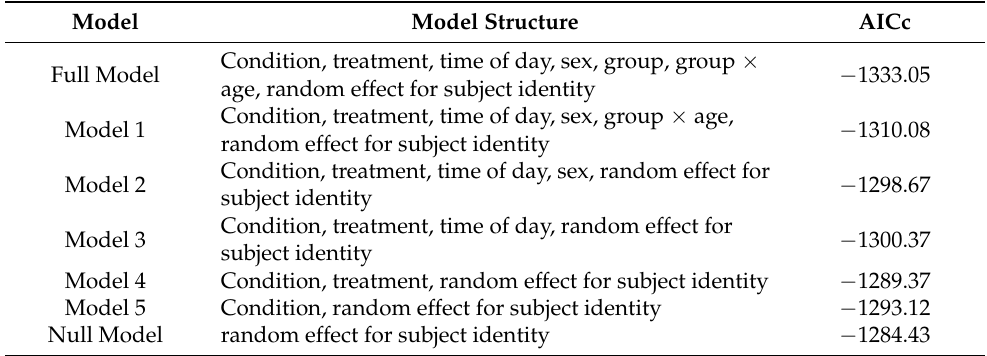
Table 5. Model structures and AIC values obtained during model selection for affiliative behaviours.